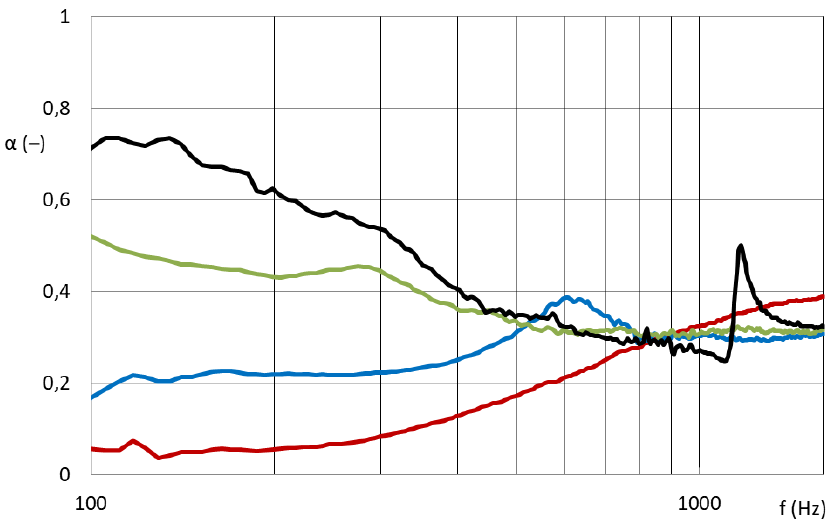
Figure 12. Sound absorption coefficient depending on sound frequency (100–1600 Hz). Grid M101 with a nanofibrous membrane from both sides and filled with the volume nanofibrous structure measured with different air gaps: red: 0 mm; blue: 50 mm; green: 100 mm; black: 150 mm.